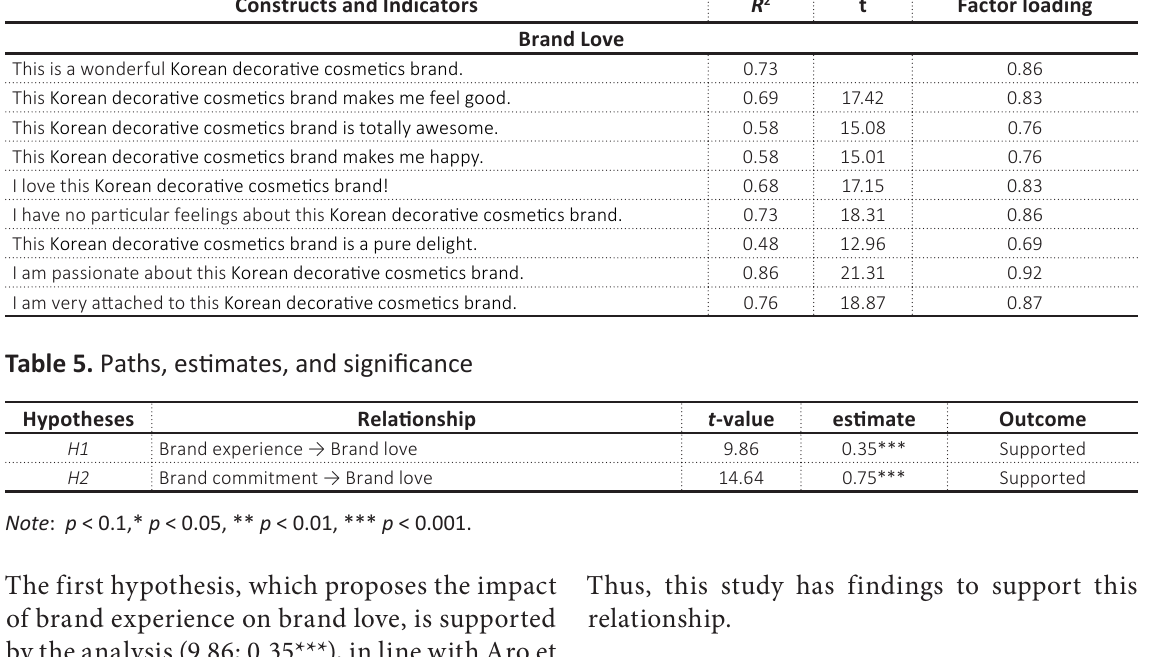
Brand commitment